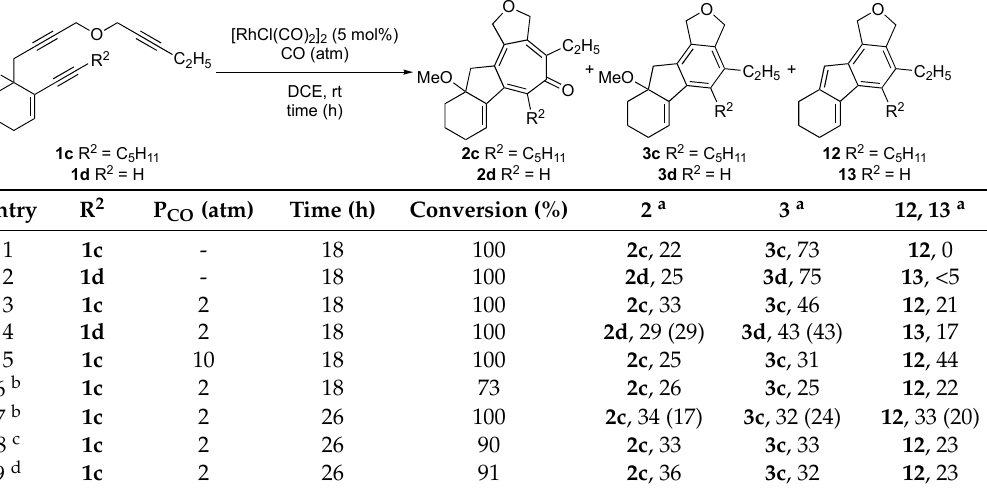
Table 2. Use of carbon monoxide as CO source for the [2+2+2+1] carbonylative cycloaddition and competing pathways of triyne 1c , d .